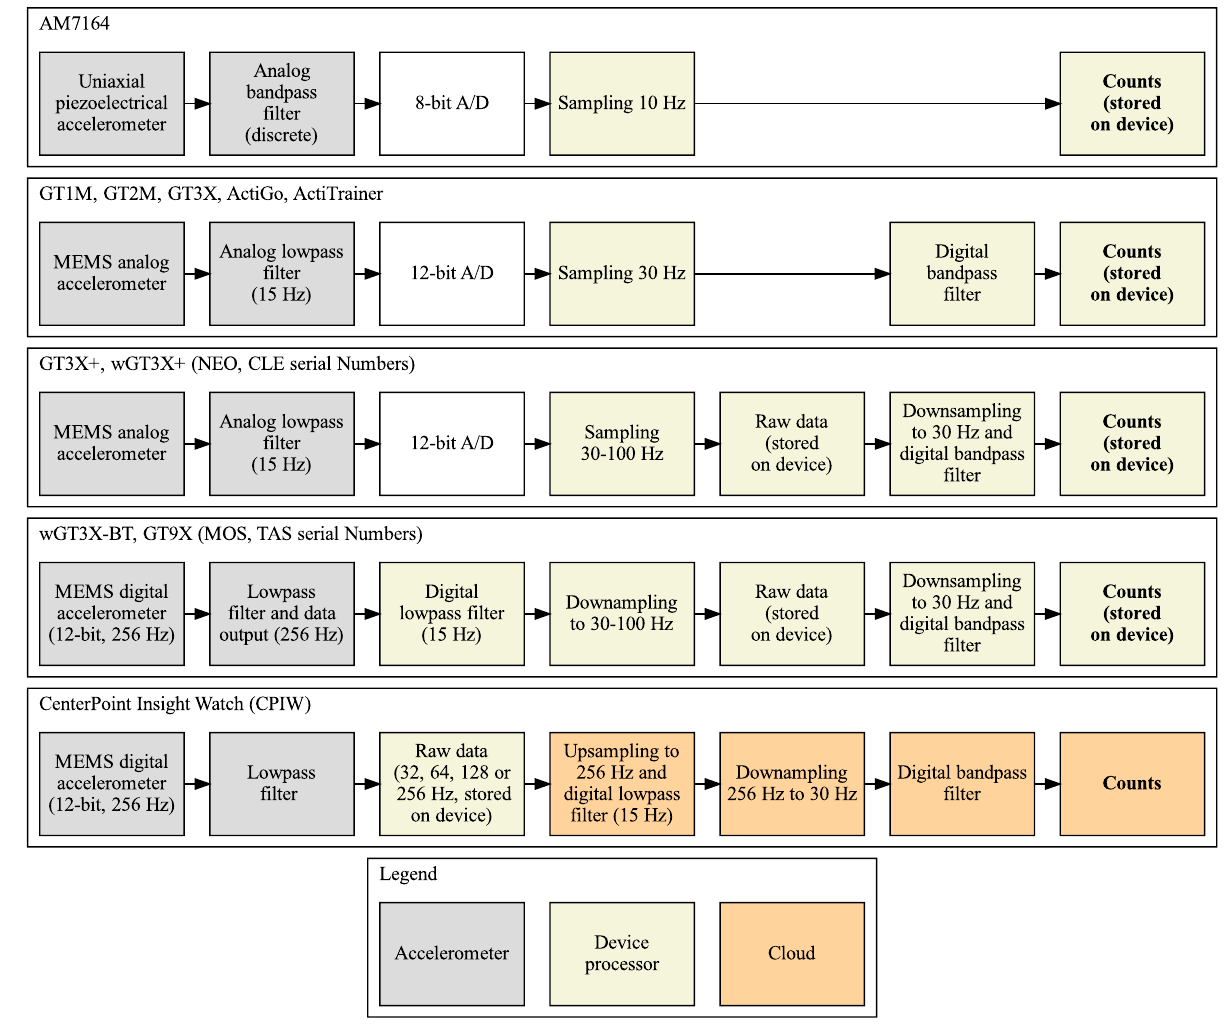
Figure 1. Conceptual schematic of the computational pipeline for generating counts for five generations of ActiGraph accelerometer models (rows). Raw data measures acceleration in free fall acceleration (g) units. Functions performed by the microprocessor, the accelerometer and in the CentrePoint cloud are highlighted in yellow, gray and orange, respectively. The analog band-pass filters in AM7146 are implemented using a series of cascaded op amp circuits, the half magnitude points for the lower and upper cutoff frequencies are 0.21 and 2.28 Hz, respectively 14 . For the analog low-pass filters the − 3 dB cutoff frequency is shown in parenthesis for each block. A/D is the analog-to-digital converter (white blocks), shown together with the bit size of the quantizer. The counts data blocks are highlighted in